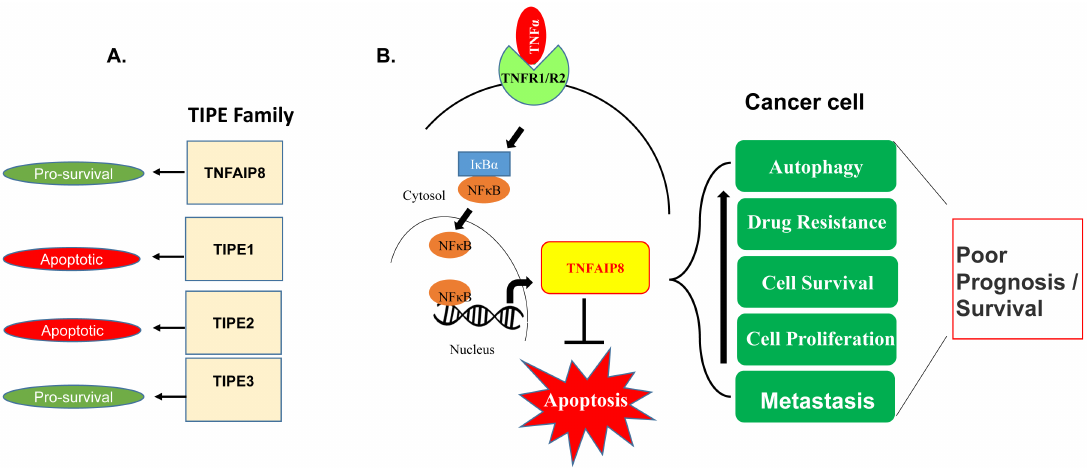
Figure 5. ( A ) The biological roles of TIPE family proteins in cell survival and cell death are suggested. ( B ) The schematic model represents the involvement of TNFAIP8 in the regulation of different cellular processes in cancer